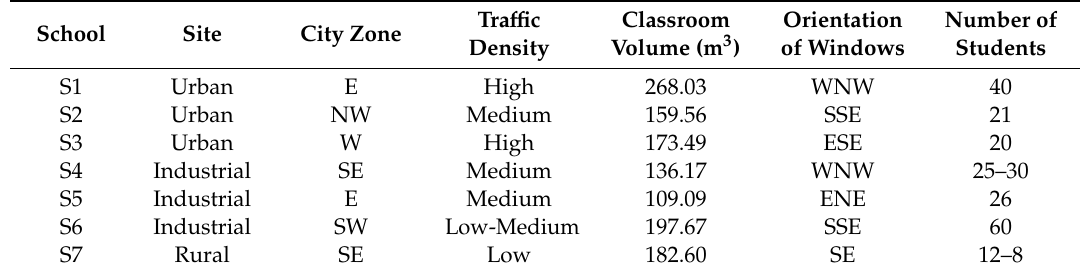
Table 1. Main characteristics of the studied schools. Legend: N: North; S: South; E: East; W: